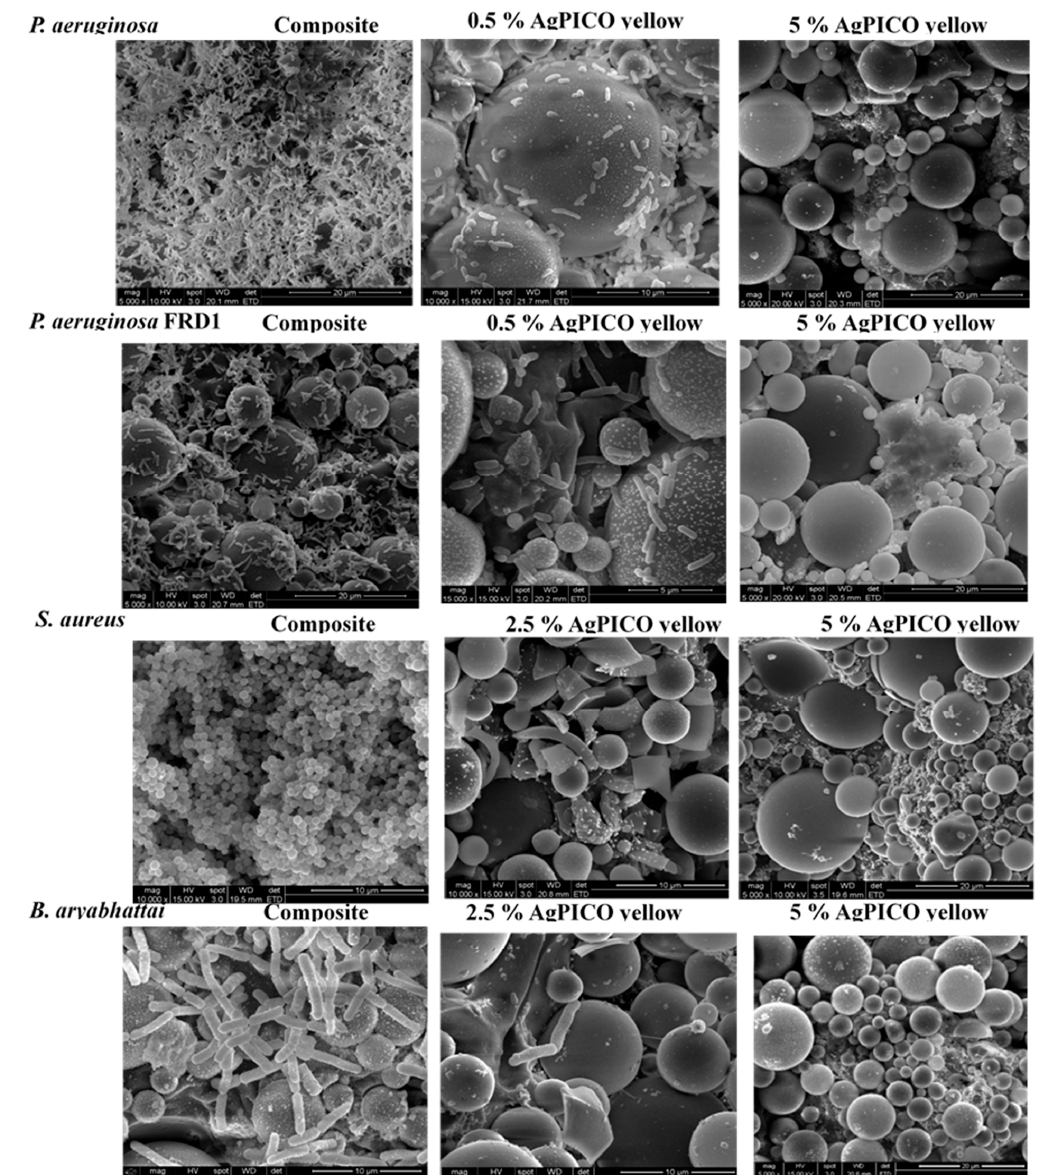
Figure 6. Scanning electron microscope (SEM) micrographs of biofilms grown on the surface